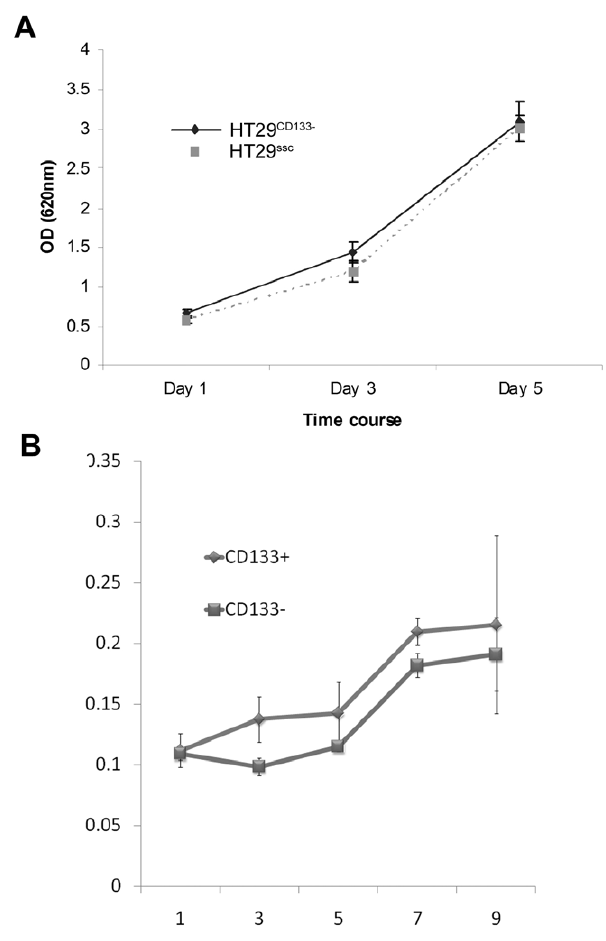
Figure 4. Effect of CD133 on proliferation. Cell proliferation was evaluated after knockdown of CD133 in HT29 (Figure 4a) and sorting of SW480 into pure CD133 + and CD133 2 populations (Figure 4b). A time course assay was performed over several days with no association seen between CD133 and cell numbers.